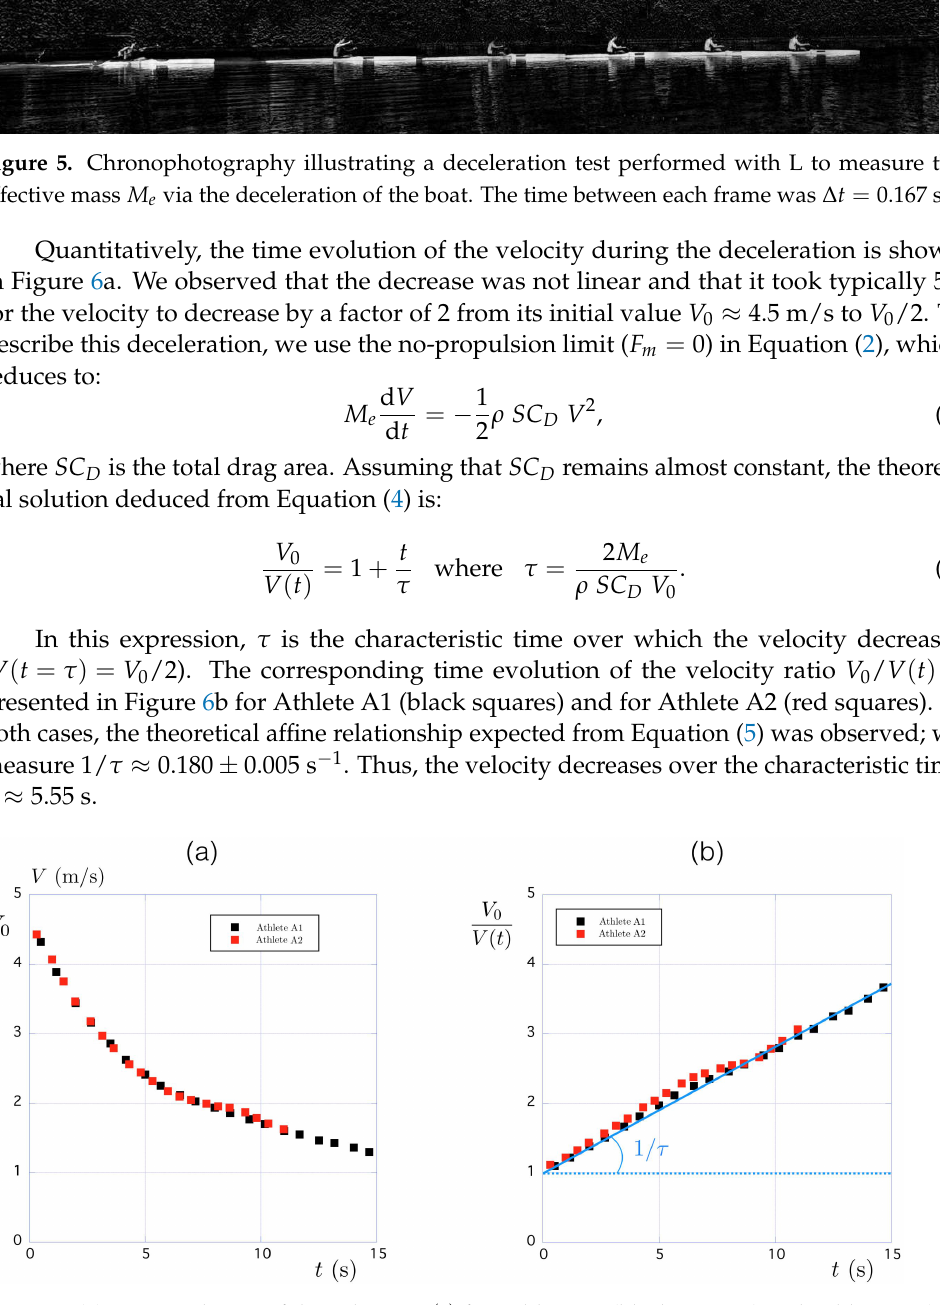
Figure 6. ( a ) Time evolution of the velocity V ( t ) for Athlete A1 (black squares) and Athlete A2 (red squares). ( b ) Time evolution of the velocity ratio V 0 / V ( t ) for Athlete A1 ( V 0 = 4.76 m/s) and Athlete A2 ( V 0 = 4.98